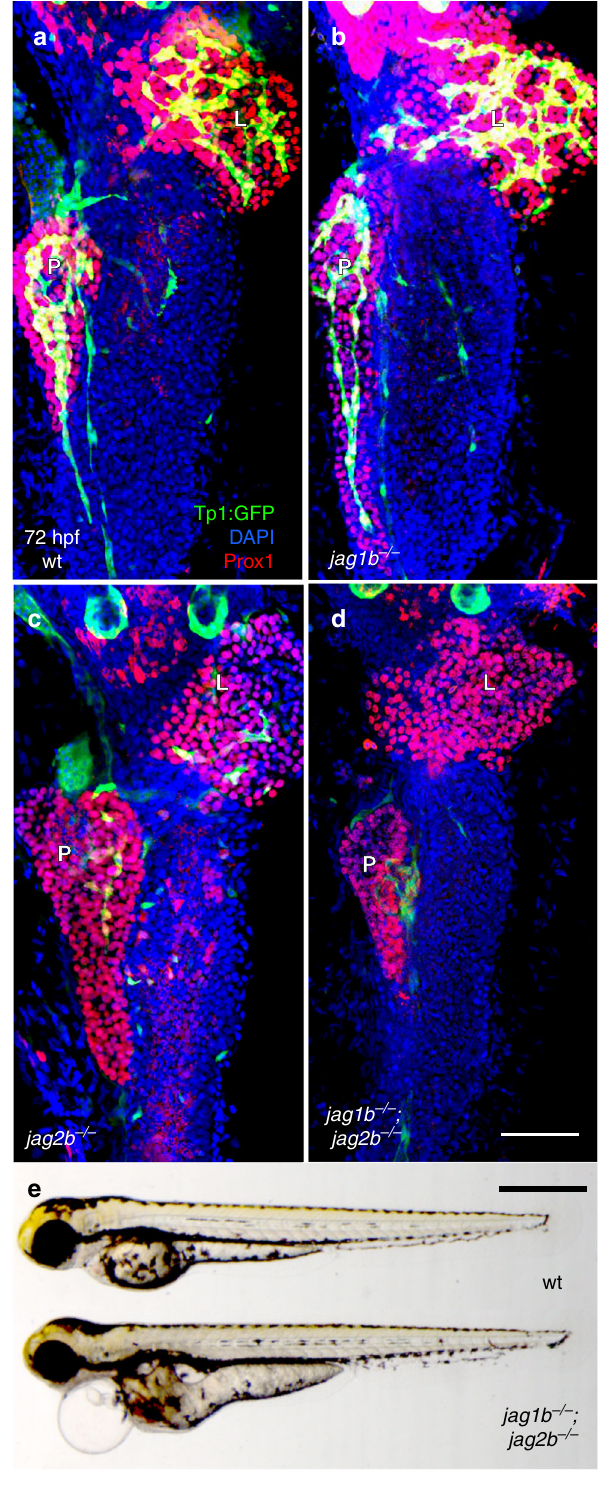
(Supplementary Fig. 2c, d). Tp1:GFP expression is also observed in a subset of pancreatic Islet1 expressing endocrine cells (Supplementary Fig. 2d). Homozygous jag1b b1105 mutant 72 hours post fertilization (hpf) embryos ( n > 15) show no obvious decrease in Tp1:GFP